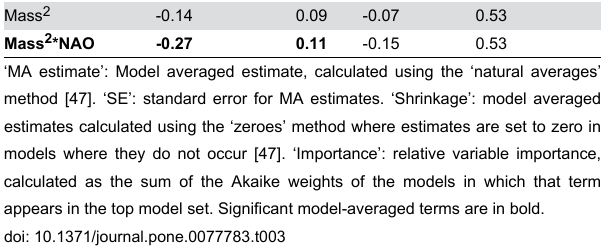
Table 4. Results from a Bayesian multivariate response model investigating the posterior correlation between body mass and number of juveniles.